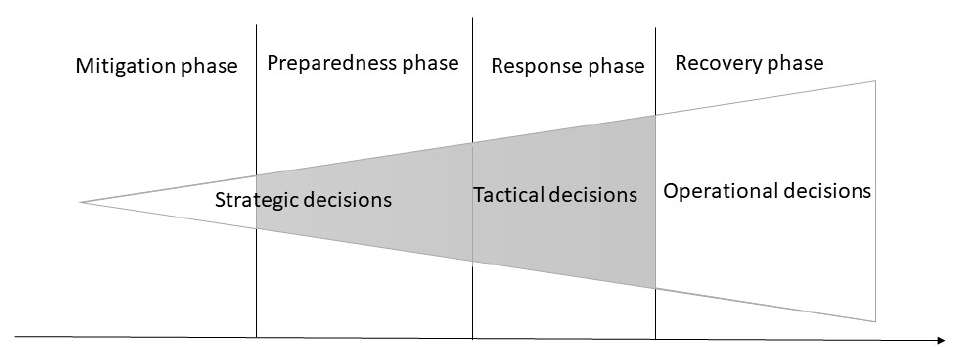
Figure 3. Di ff erent disaster operational phases and supply chain decision Figure 3. Different disaster operational phases and supply chain decision categories.